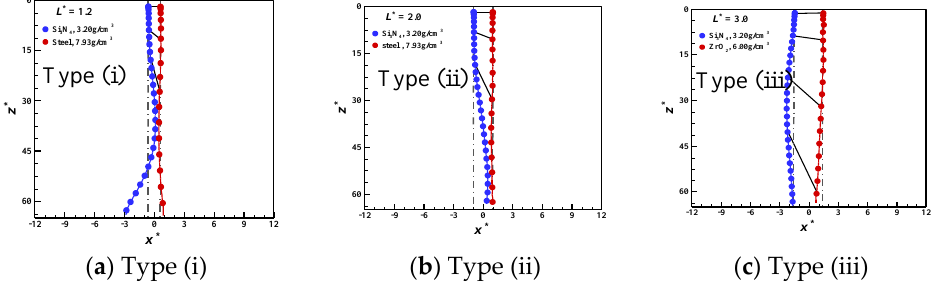
Figure 13. Typical settling trajectories of two particle settling side by side, with an example for each type.